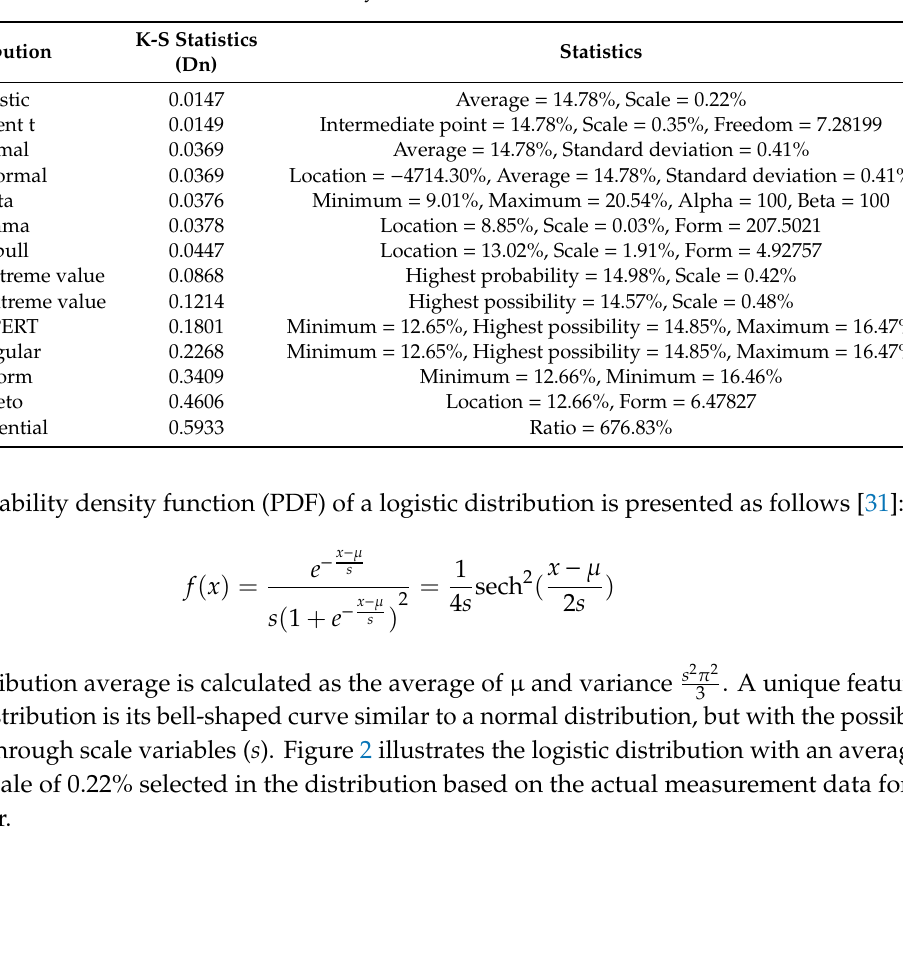
Table 2. Probability distribution test